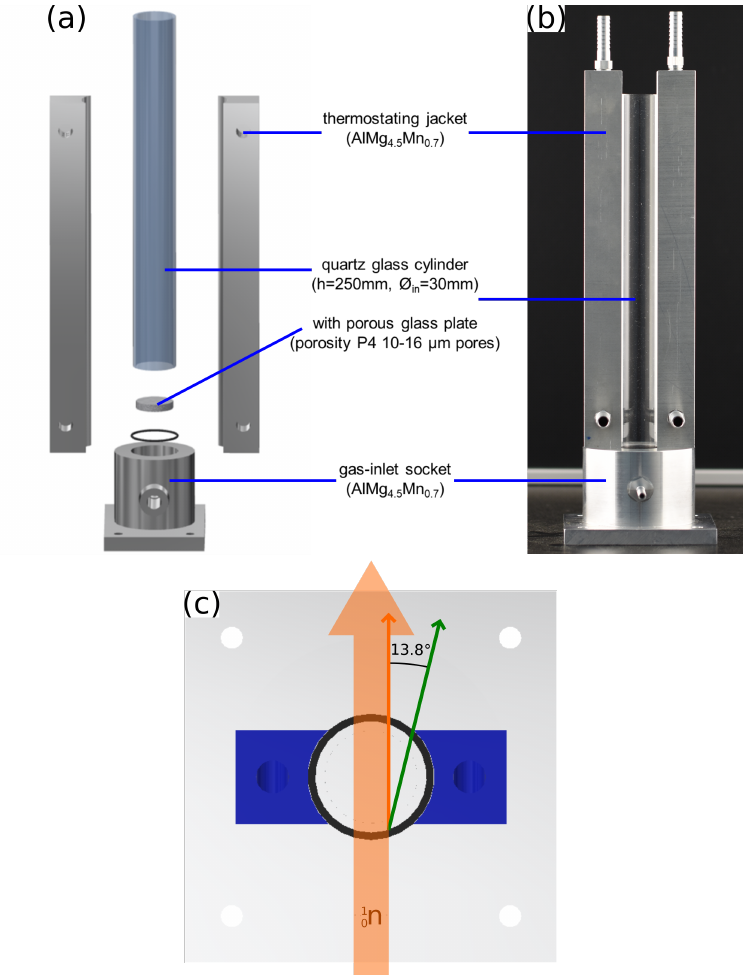
Figure 1. Individual foam cell. ( a ) Explosion-view drawing and ( b ) photograph in front view. ( c ) Schematic top view. The individual foam cells consist of a quartz glass cylinder, thermojackets, and a gas-inlet socket. The neutron beam (highlighted in orange) passes the cell perpendicular to the thermojackets in variable height. For the estimation of the minimal range of scattering angles accessible, a scattering event at the (geometrically) least favorable position is considered (green